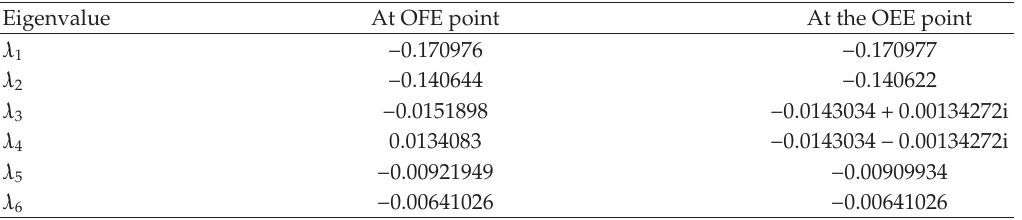
Table 2: The eigenvalues of the Jacobian of system (cid:3) 2.1 (cid:6) evaluated at the OFE point and at the OEE point. Eigenvalue At OFE